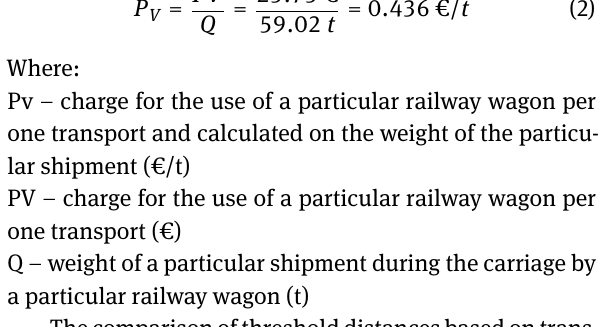
between the cargo and they block cargo in the upper layer against movement in the longitudinal direction. It was nec-